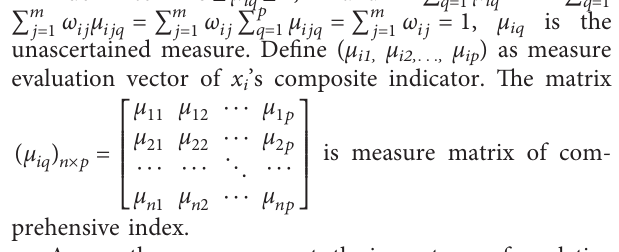
Table 2: Saaty’s scale for AHP pairwise comparisons [42,